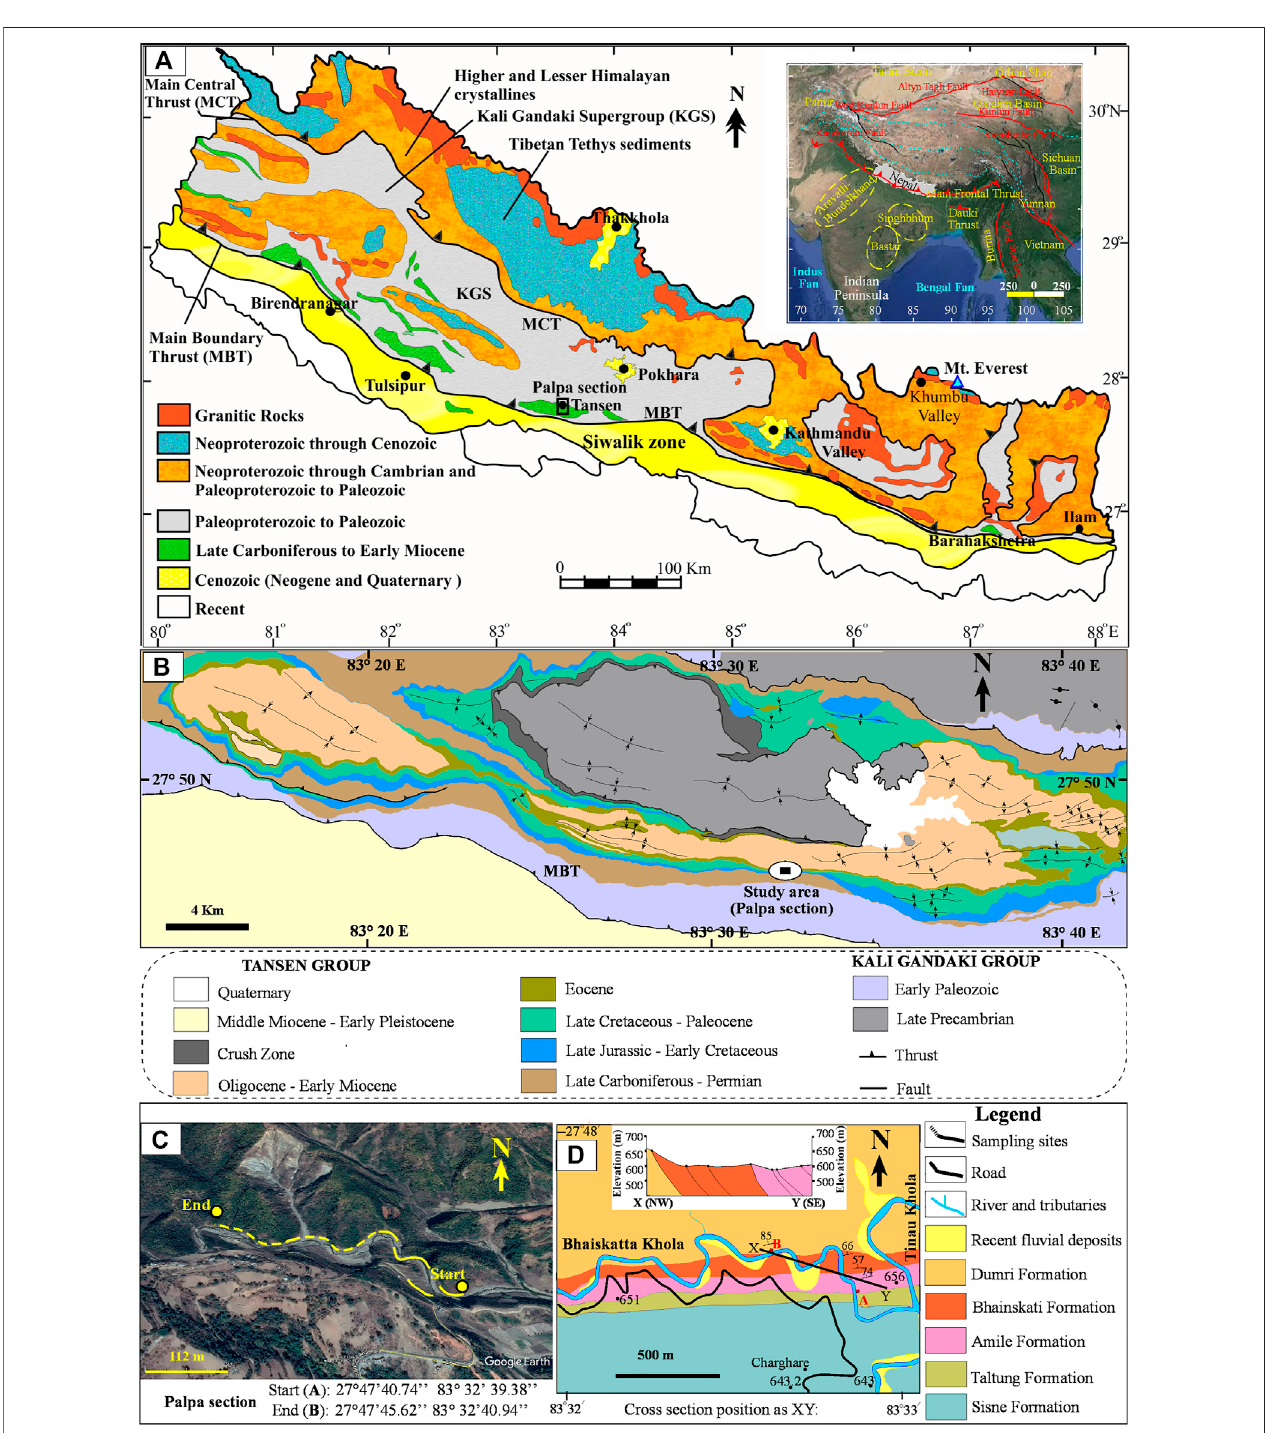
FIGURE1| GeologicalframeworkofNepal. (A) Simpli fi edgeologicalmapoftheNepalHimalayashowingthelocationofthestudyarea(Palpasection)intheTansen area, modi fi ed after Khatri et al. (2017). (B) Detailed geological map of the western Nepal. The black rectangular box indicates the Palpa section, modi fi ed after Sakai (1983), Sakai (1984), Dhital (2015). (C) Google map (http://earth.google.com/) showing the sampling route in the Bhaiskatta Khola from 27 ° 47 ′ 40.74 ″ 83 ° 32 ′ 39.38 ″ to 27 ° 47 ′ 45.62 ″ 83 ° 32 ′ 40.94 ” . (D) Detailedgeologicalmapofthestudyareaandthecross-sectionforthesamplespro fi leshowingthelateCretaceoustoOligocene- early Miocene strata.